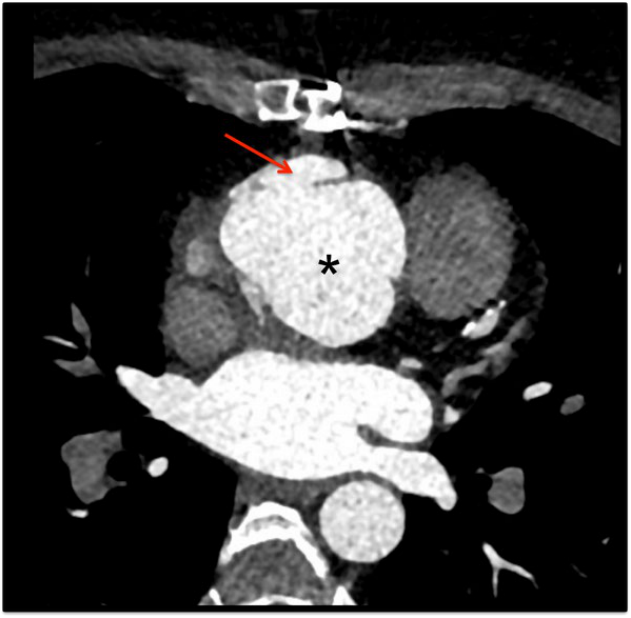
Figure 1. CT scan: Pseudoaneurysm of the proximal graft anastomosis (ar- row); native aortic root (*).